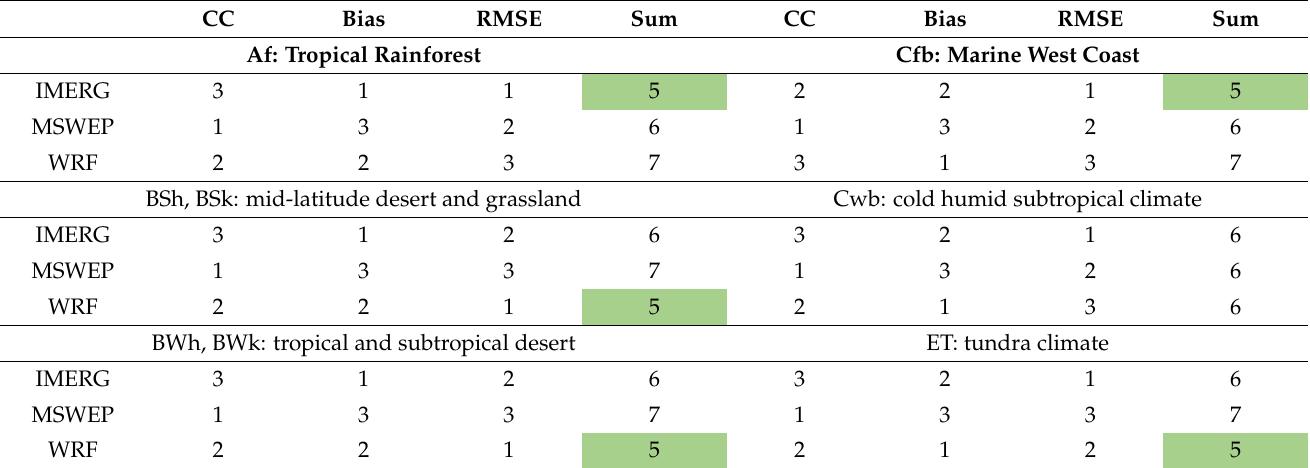
Table 4. Performance ranking for GPM IMERG, MSWEP, and WRF in major climate zones in Peru, where the best scores were highlighted in